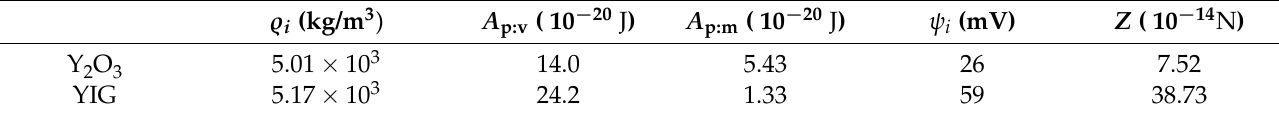
Table 3. Material properties and interaction coefficients of the Y 2 O 3 and YIG nanoparticles. (cid:36) i (kg/m 3